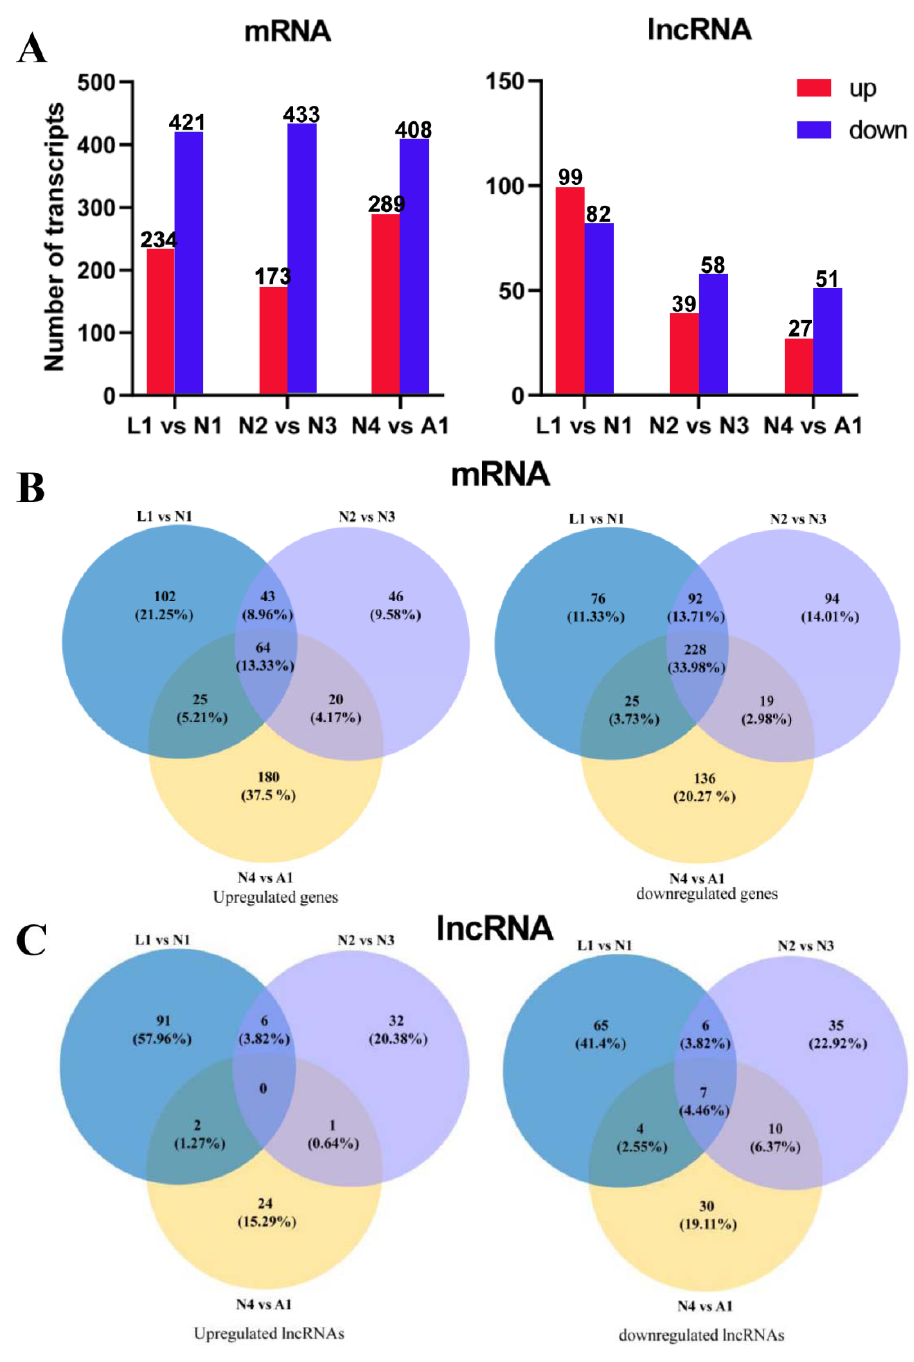
Figure 4. DE lncRNAs and mRNAs in the molting processes of different development stages in Panonychus citri . ( A ) Up- and downregulated lncRNAs and mRNAs in the molting processes of different development stages. Venn diagram of up- and downregulated differentially expressed mRNAs ( B ) and lncRNAs ( C ) in the molting processes of different development stages. L1: late larva; N1: early protonymph; N2: late protonymph; N3: early deutonymph; N4: late deutonymph; A1: early adult.